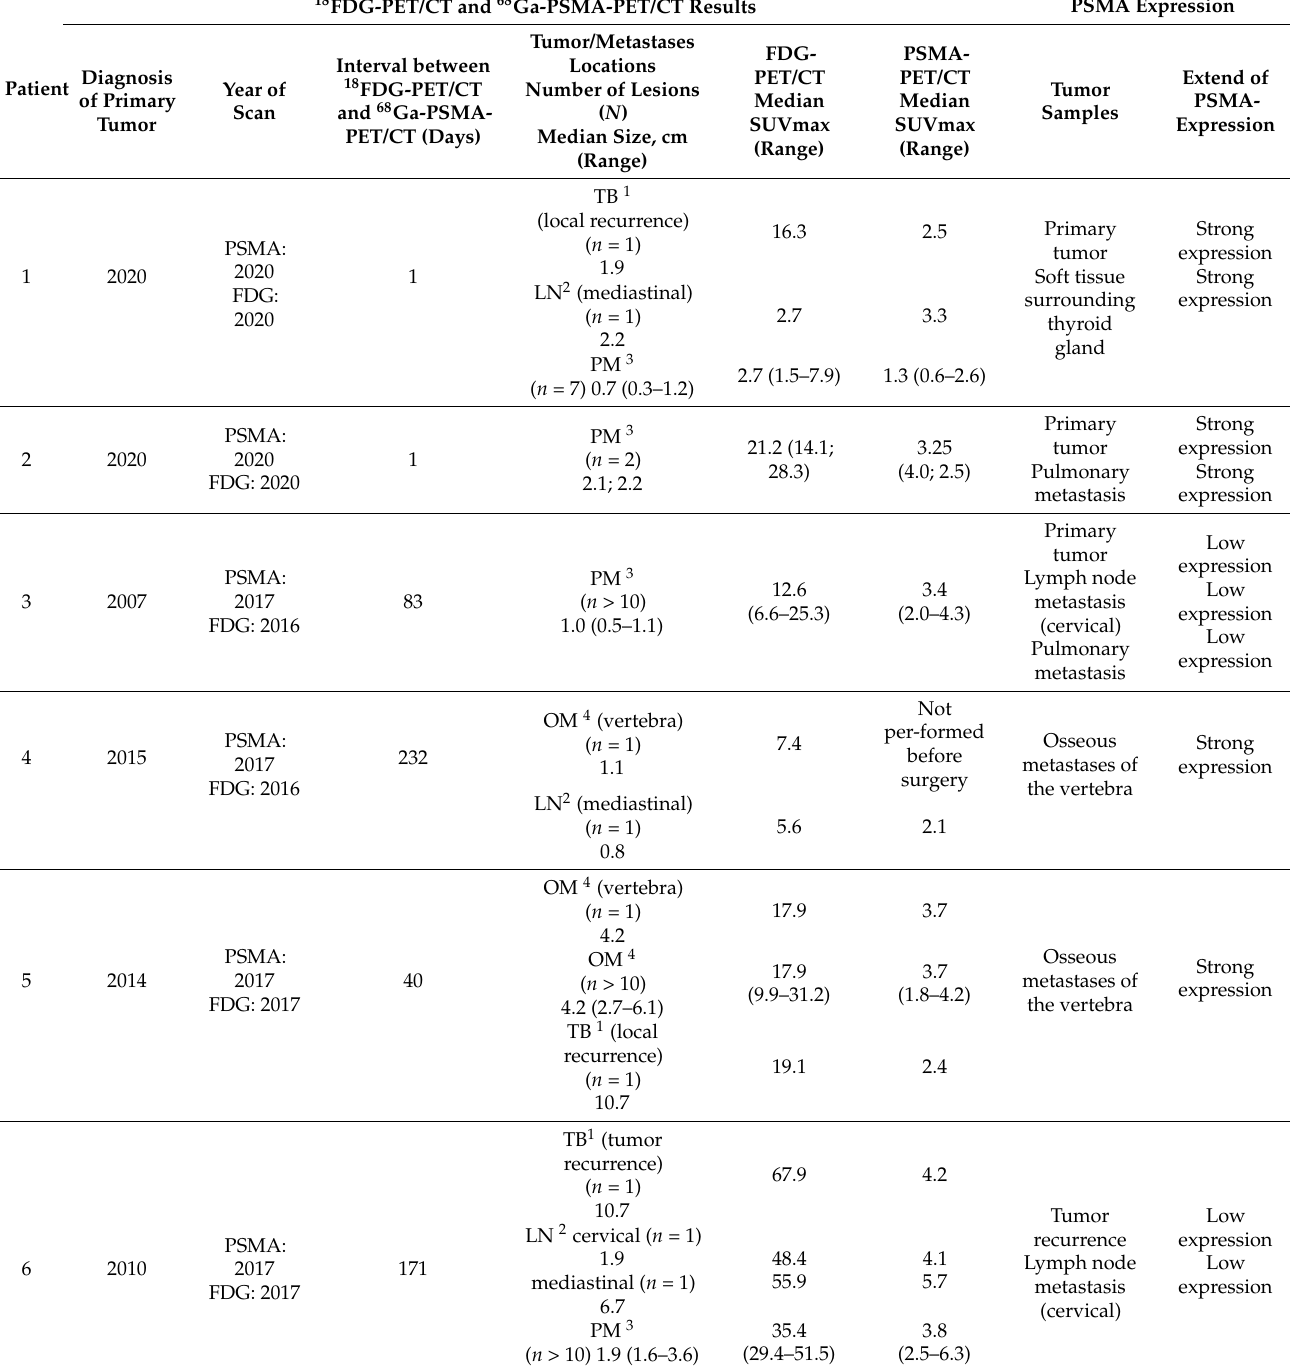
Table 2. Lesion SUVmax in 18 FDG-PET/CT and 68 Ga-PSMA-PET/CT of (metastatic) disease locations and extent of PSMA expression in tissue samples for each